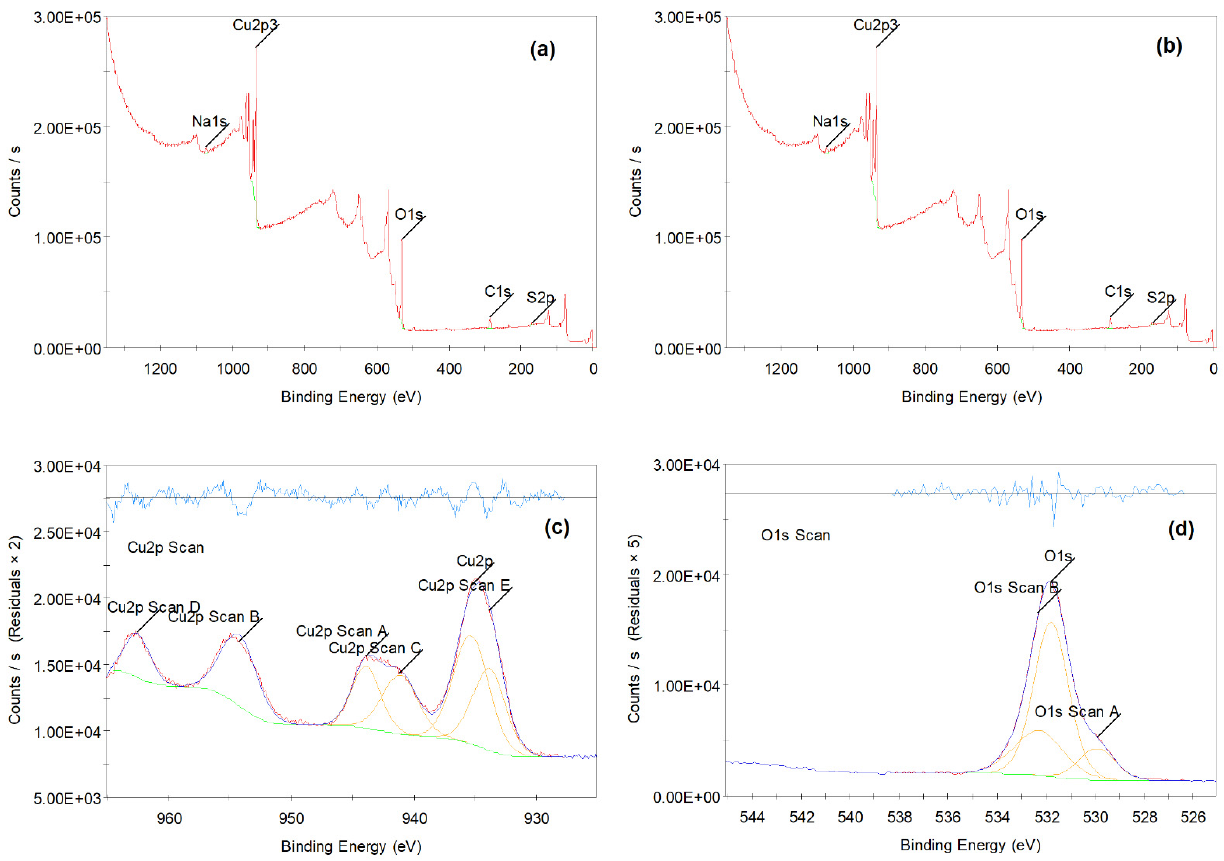
Figure 3. Transmission electron microscope (TEM) images for ( a ) CuO NPs and ( b ) G CuO NPs.